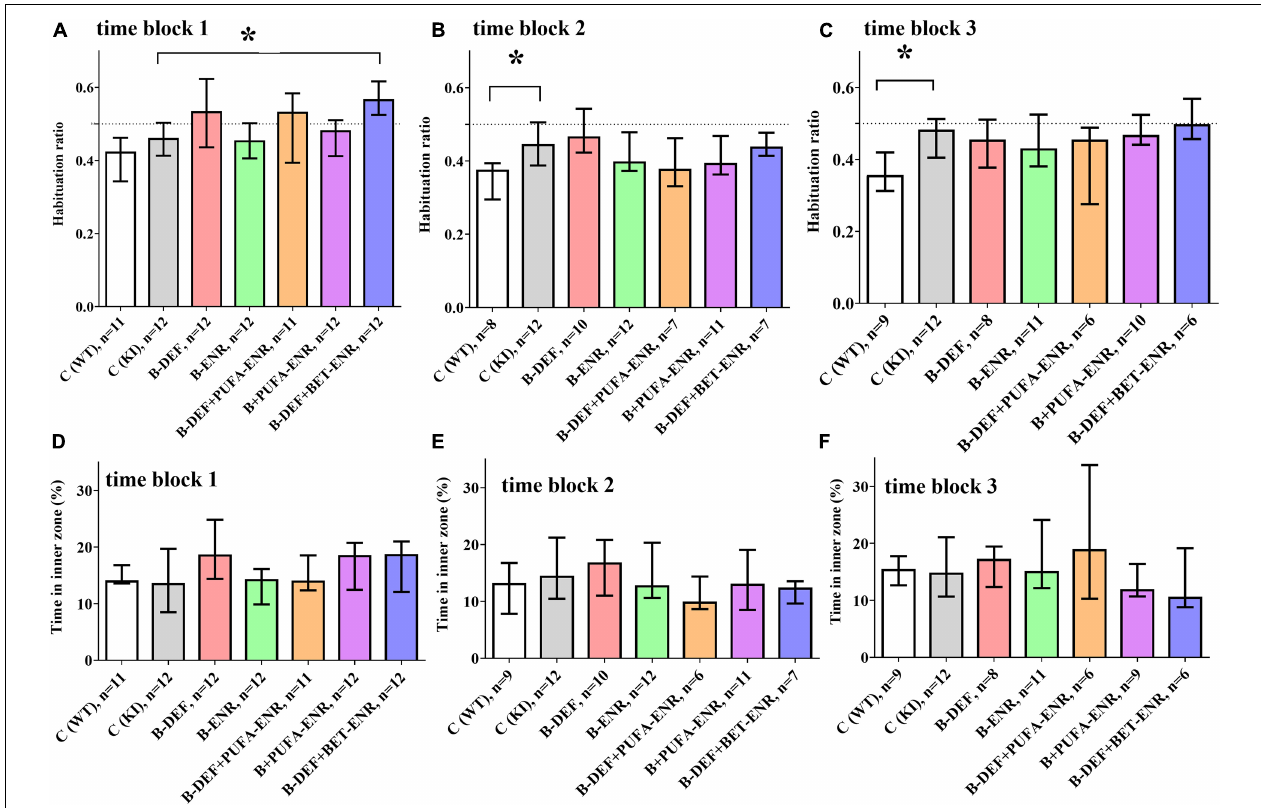
FIGURE 4 | Open field testing in time block 1–3: (A,C,E) intrasession habituation (lower habituation ratio meaning a higher level of intrasession habituation) and (B,D,F) anxiety-related behavior; median ± IQR; outliers beyond 3-fold IQR removed; p < 0.05 (Mann-Whitney- U -test) considered statistically significant (*).